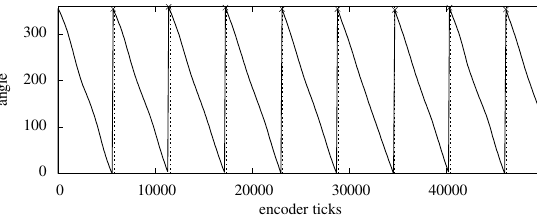
Figure 3. Determination of encoder RPM with IMU data. The continuous line shows the IMU angles, the crosses mark the detected peaks while the dashed lines represent the zero-crossings based on the calibrated